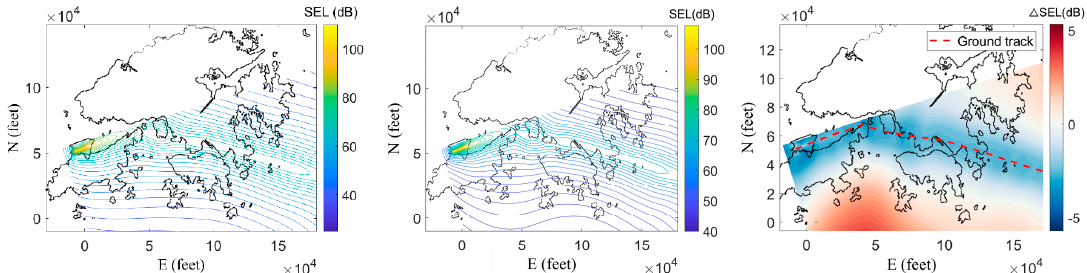
Figure 20. A330 and (virtual) B777 aircraft departing from HKIA. Noise levels (SEL) generated by flight AD2 ( left ) and BD1 ( center ) over Hong Kong city, along with their difference (obtained by subtracting the former from the latter, right